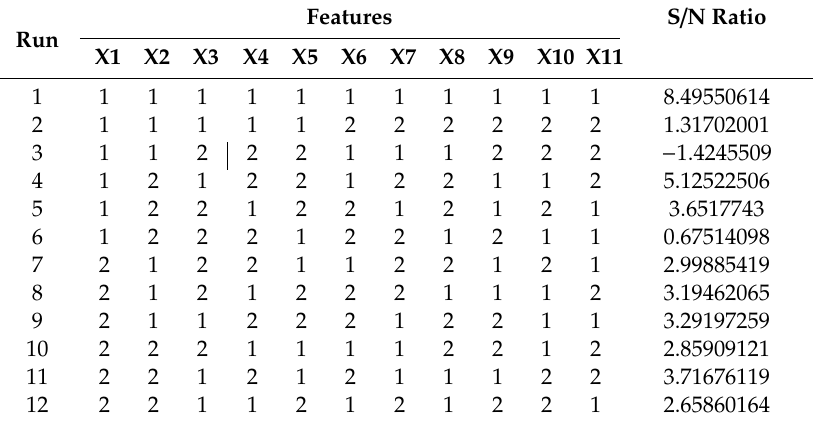
Table 8. L 12 (2 11 ) OA for the ACLR conditions.